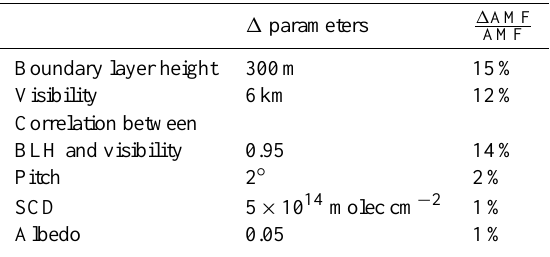
Table 2. Error contributions to the air mass factor (AMF).